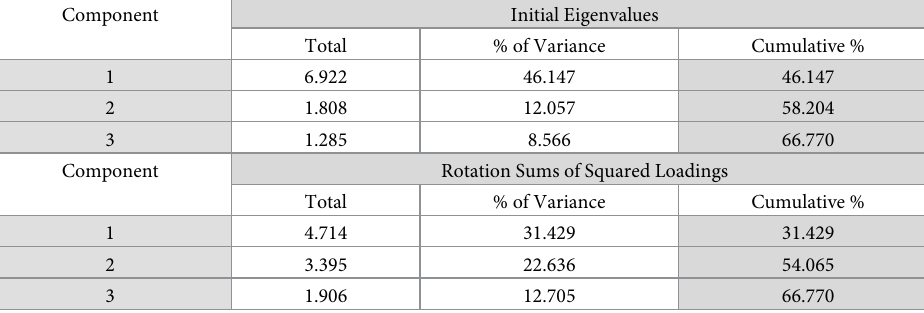
Table 4. The total variance explained by each